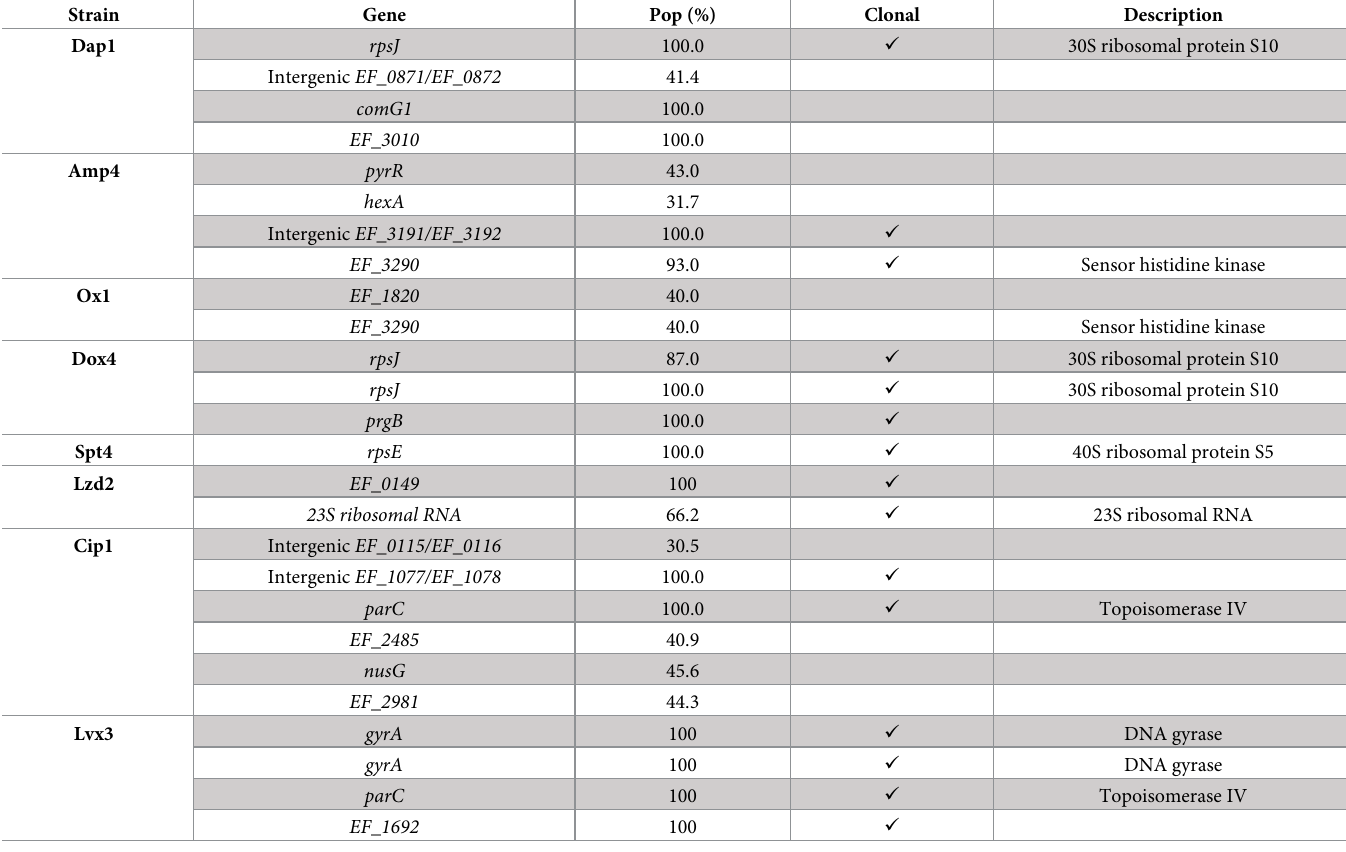
Table 2. Mutations identified in selected populations.